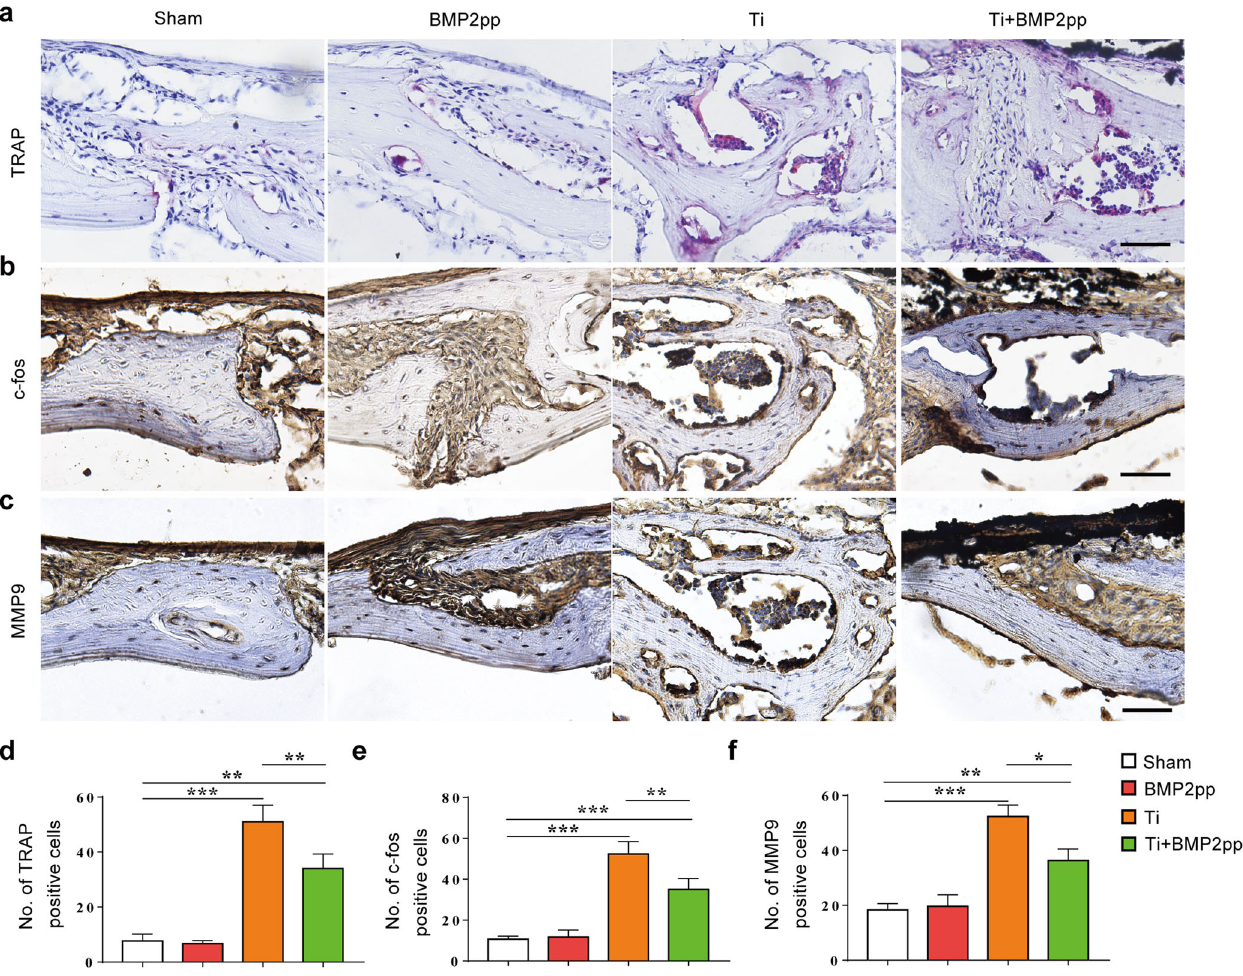
Fig. 6 BMP2pp reduced the calvarial bone resorption and in fl ammatory factor release stressed by Ti particles in mice. a Representative images of TRAP histological staining. Images of b c-fos, and c MMP9 immunohistochemical staining of calvarial bone. scale bars: 50 μ m. The number of d TRAP, e c-fos, and f MMP9 staining positive cells, n = 8. All the data are presented as the average ± standard deviation